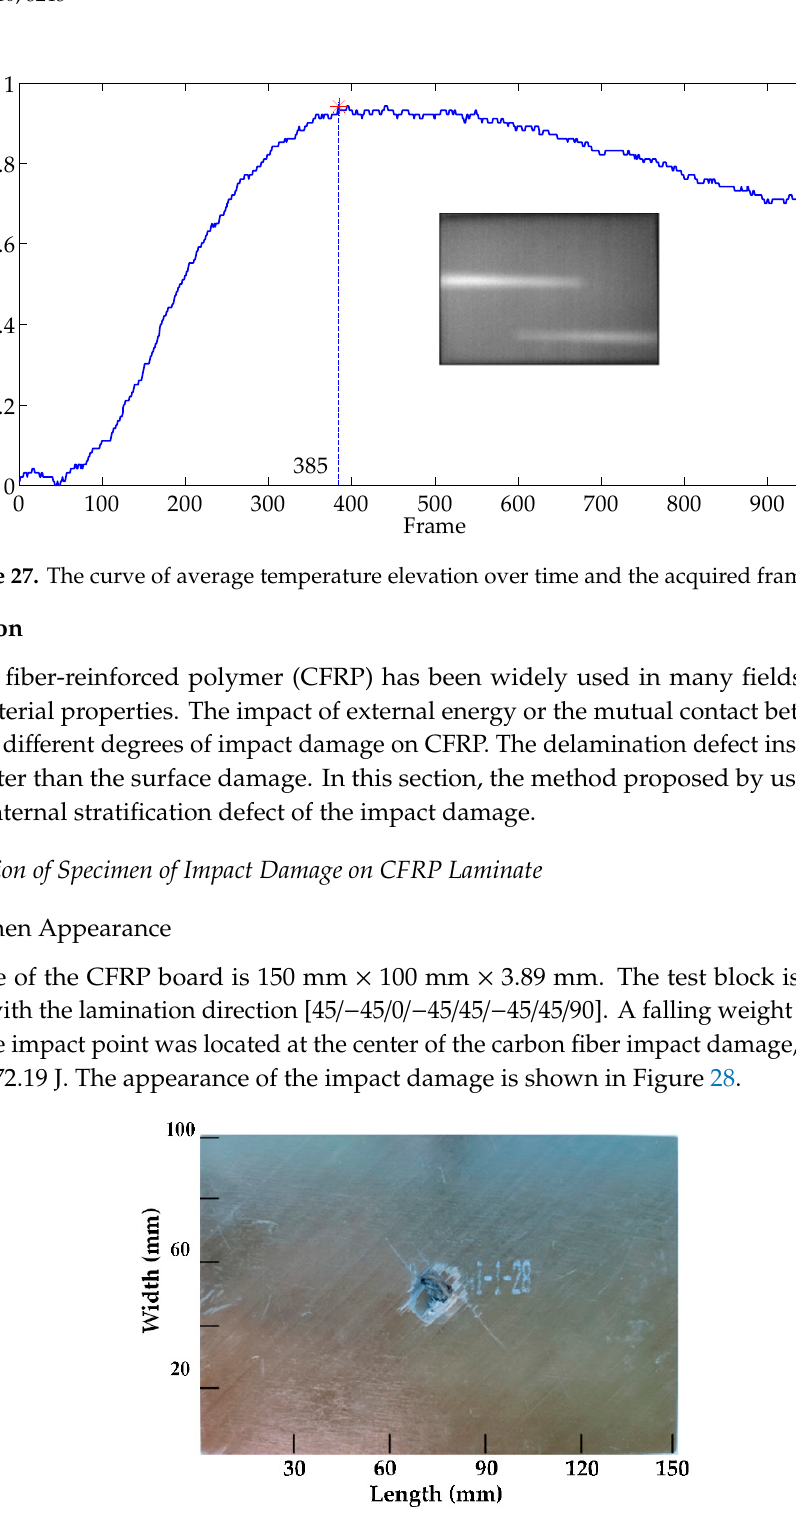
Figure 28. The specimen of impact damage of carbon fiber-reinforced plastics (CFRP).